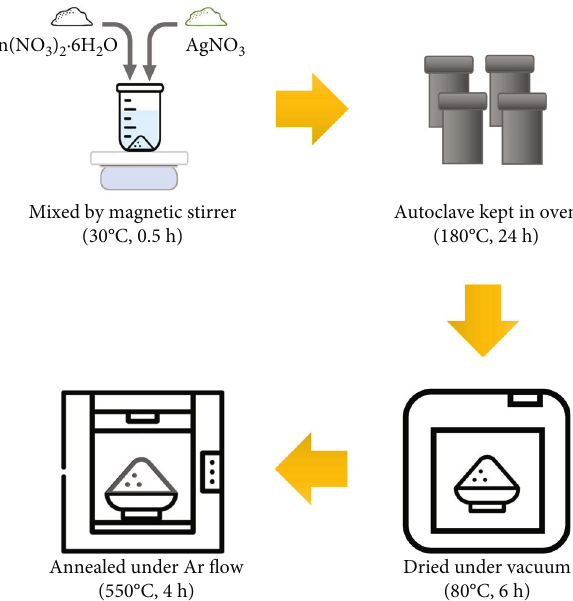
Figure 1: Schematic of the synthesis method.